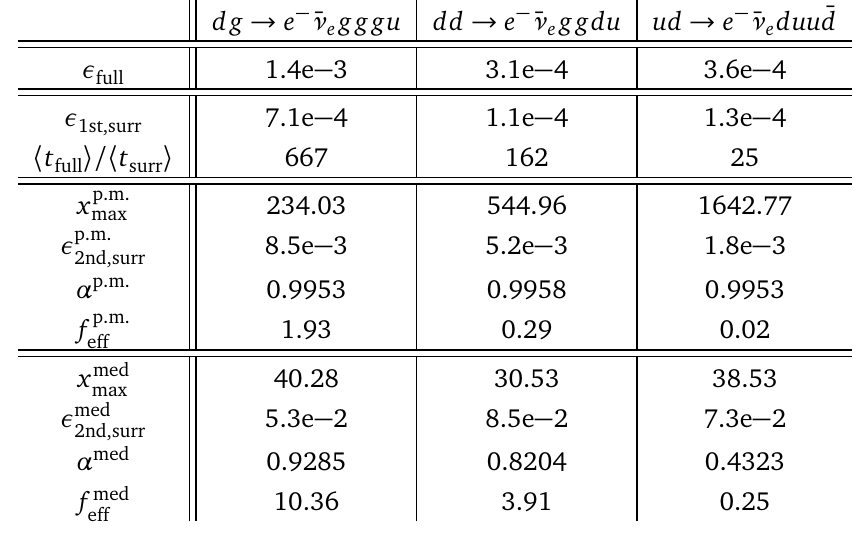
Table 4: Performance measures for partonic channels contributing to W + 4 jets pro- duction at the